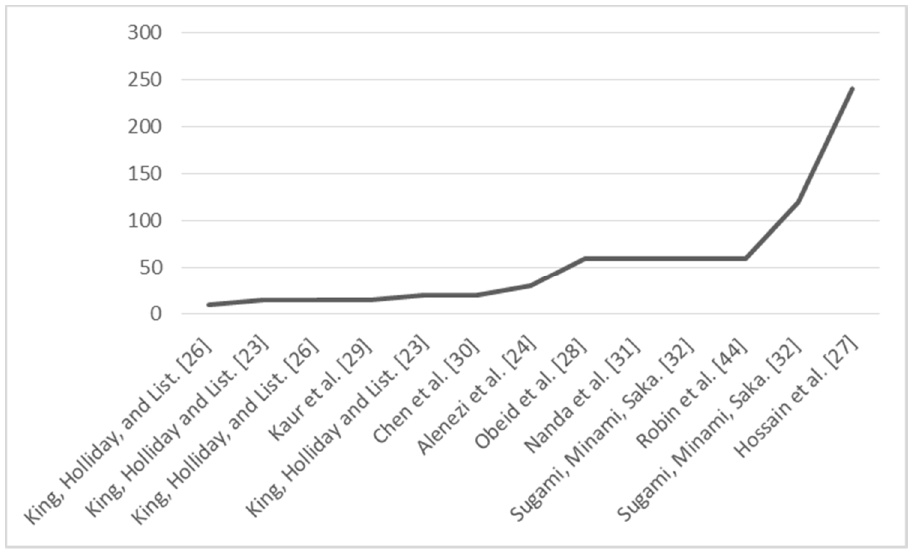
Figure 11. Residence time (minutes) in hydrothermal experiments with vegetable oil.